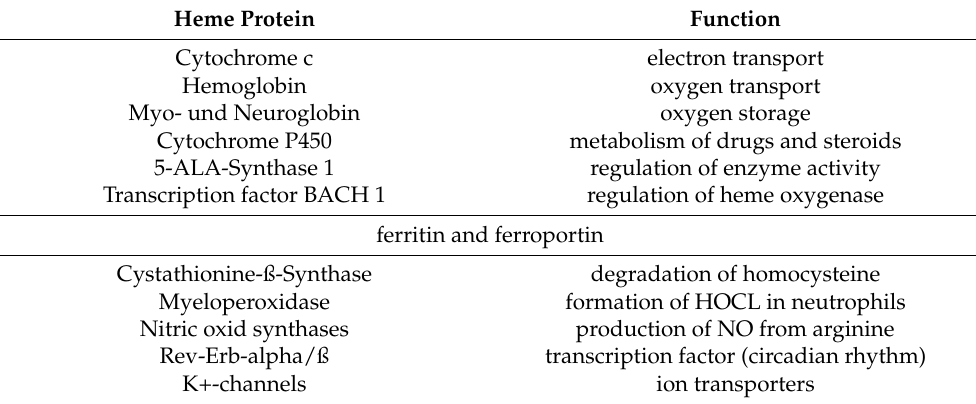
Table 1. Functions of heme in human cellular